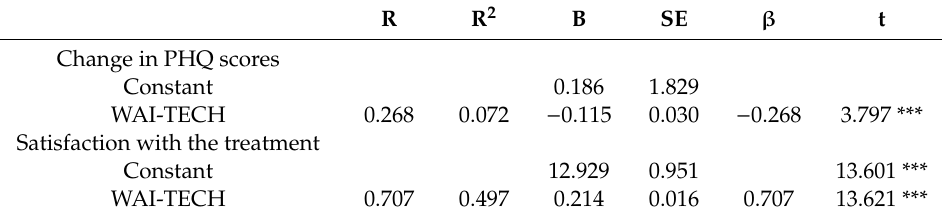
Table 4. Simple linear regressions of change in PHQ scores and satisfaction with the treatment. R R 2 B SE β t Change in PHQ scores Constant 0.186 1.829 WAI-TECH 0.268 0.072 − 0.115 0.030 − 0.268 3.797 *** Satisfaction with the treatment Constant 12.929 0.951 13.601 *** WAI-TECH